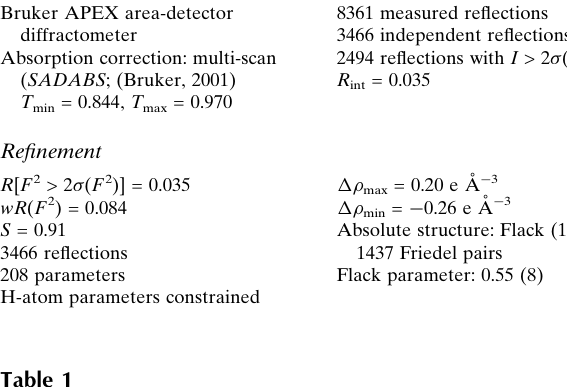
Hydrogen-bond geometry (A˚ , (cid:1)